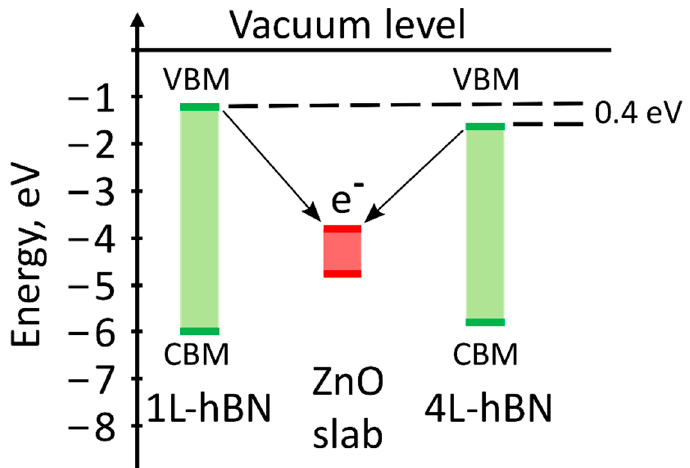
Figure 11. Schematics of band gap arrangement of freestanding 1L- h -BN and 4L- h -BN relative to w ZnO